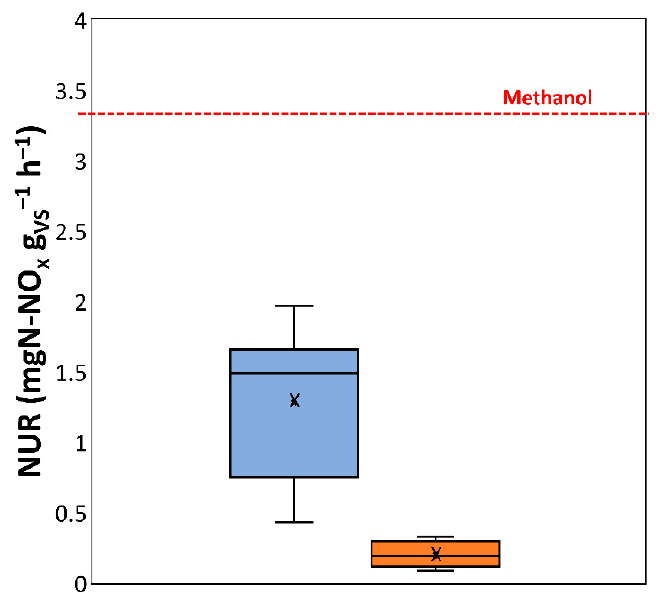
Figure 5. Results of NUR tests and comparison with the literature value [13,32] obtained with methanol dosage as a carbon source.